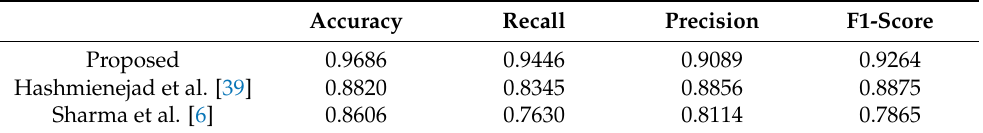
Table 5. Results of the performance